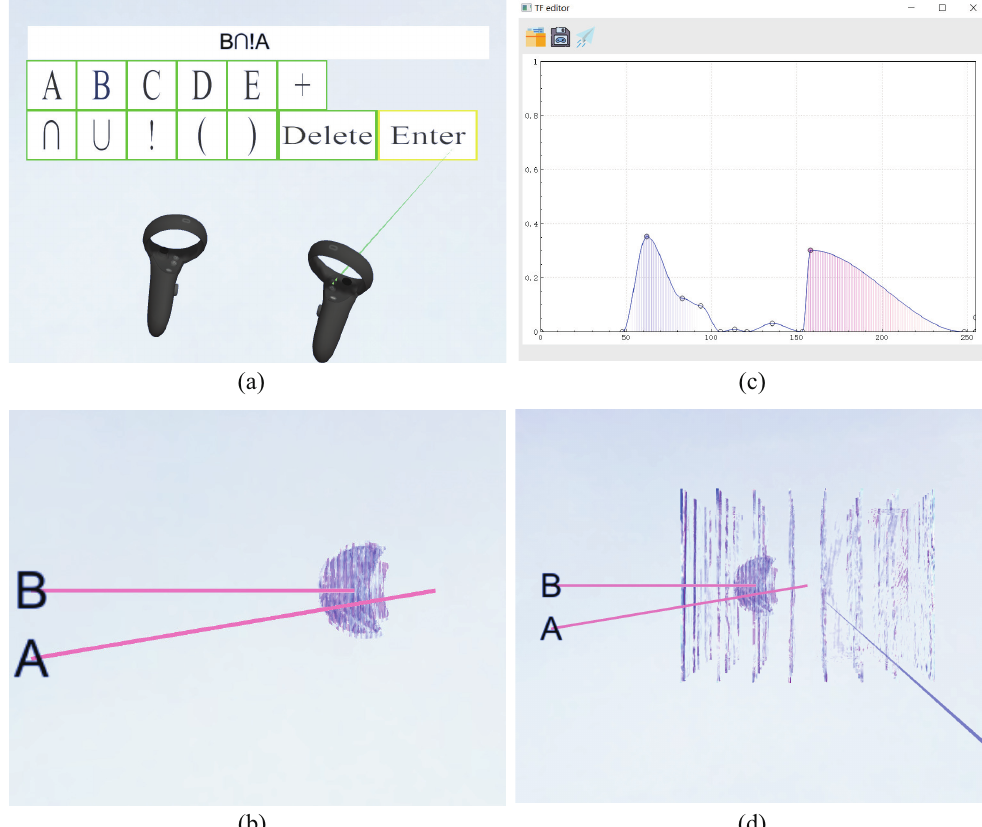
Figure 9. ( a ) The user inputs the set operation expression B ∩ !A into the virtual keyboard. ( b ) The result of B ∩ !A query in Dataset III. ( c ) User-designed transfer functions on the PC. ( d ) The combination of the cross-shaped display mode and the extracted stratigraphic